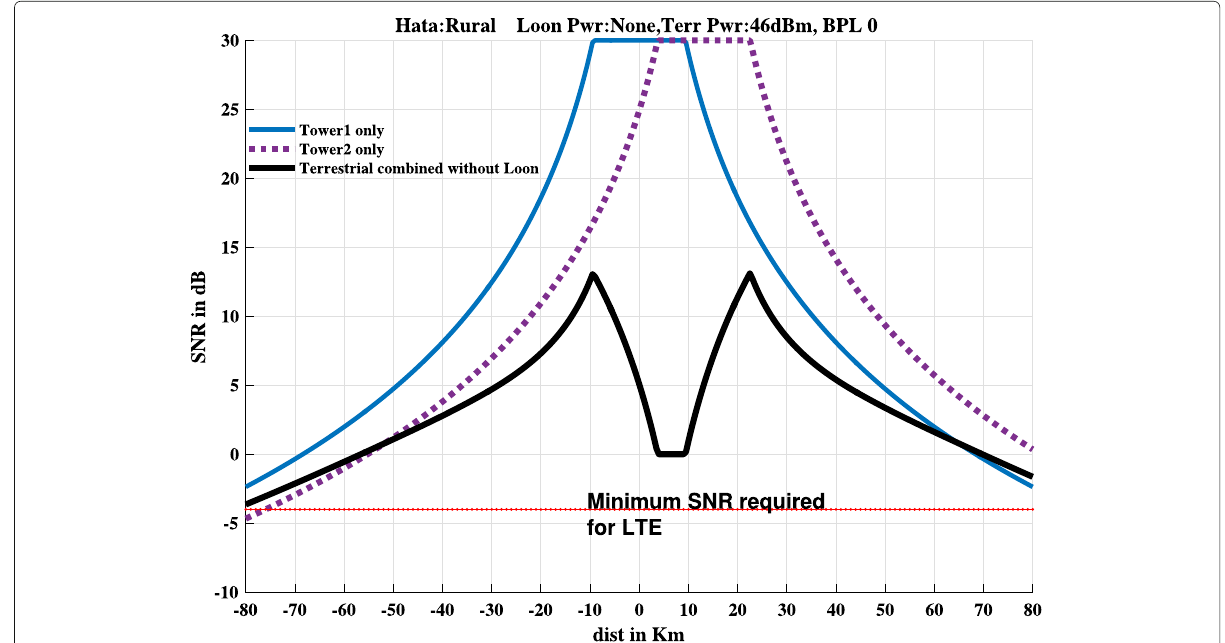
Fig. 4 Expected outdoor SINR with two rural terrestrial